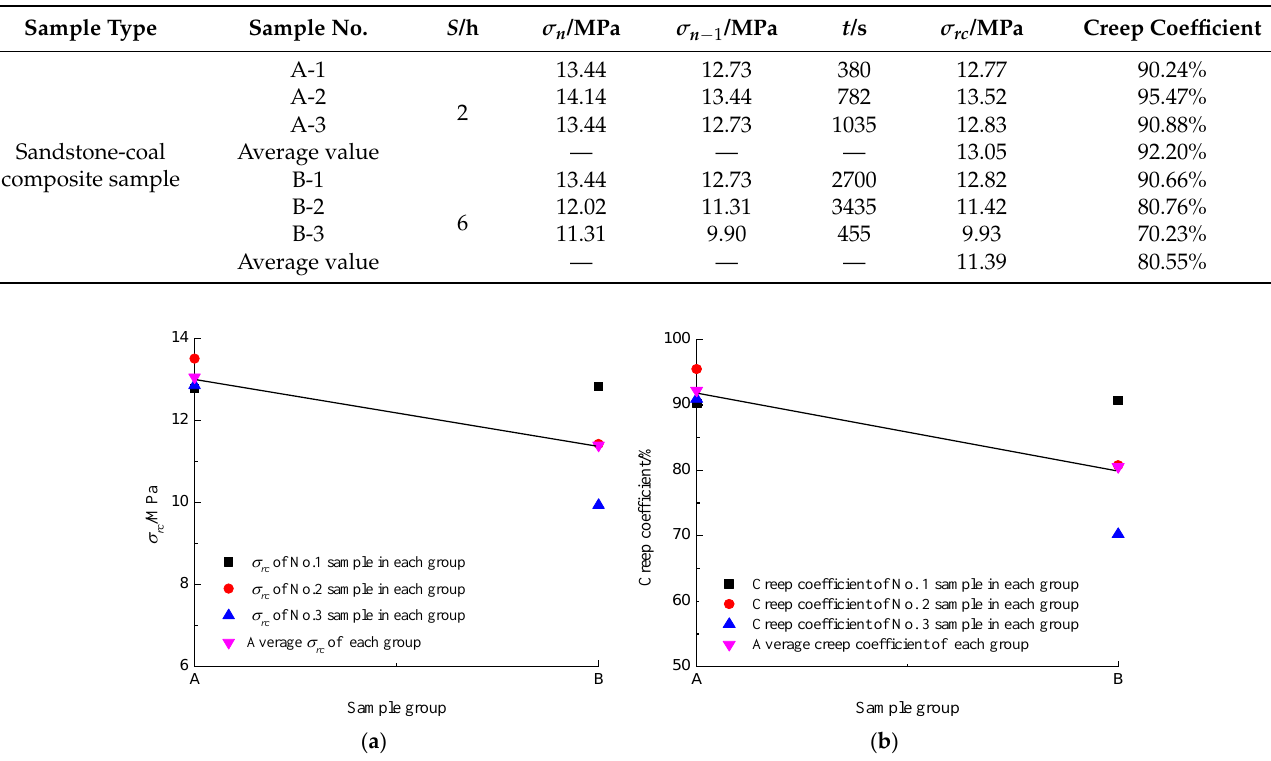
 Figure 6. Comparisons of σ rc and creep coefficients for composite samples: (a) σ rc comparison of composite samples; (b) Figure 6. Comparisons of rc and creep coefficients for composite samples: ( a ) rc Creep coefficient comparison of composite ( b ) Creep coefficient comparison of composite samples.